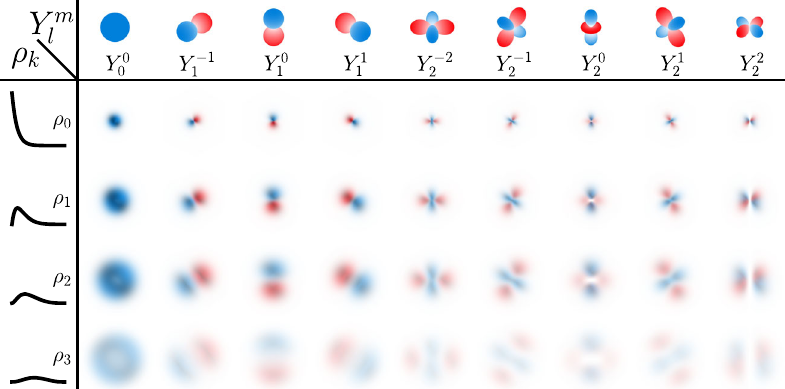
Fig. 6 Visualization of basis functions. All basis functions k g m l with K = 4 (see Eq. (13)) with different radial and angular components ρ k (Eq. (14)) and Y m l (Eq. (17)) are